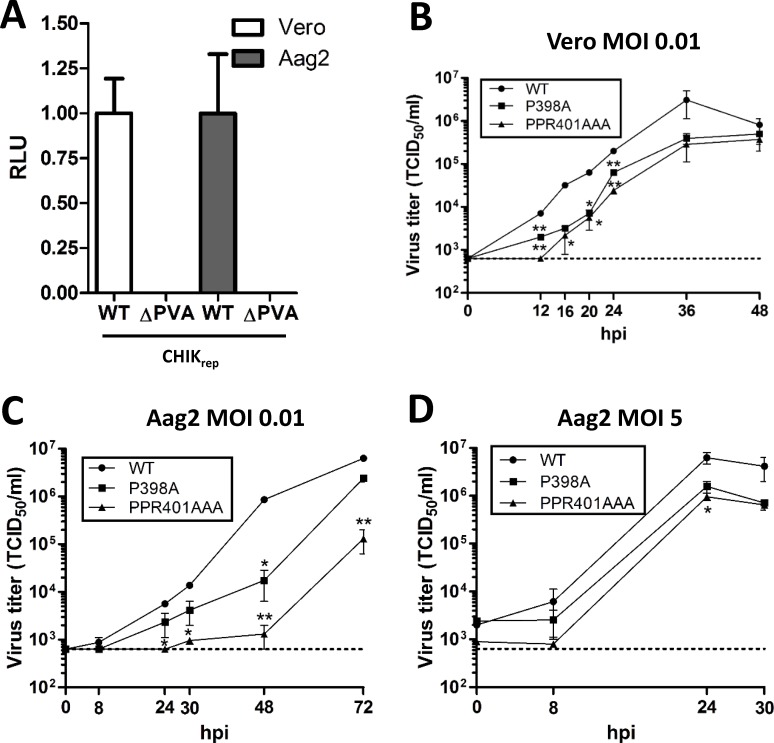
The P-rich motif is important but not essential for chikungunya virus replication in mammalian and mosquito cells.(A) Vero and Aag2 cells were transfected with in vitro transcribed RNA of CHIKrep or CHIKrepΔPVA and the relative luciferase expression was quantified at 24 hpt. Bars indicate the mean relative light units (RLU) ±standard error of the mean from three independent experiments. (B/C) Vero (B) and Aag2 (C) cells were infected in duplicate with CHIKIC, CHIKICP398A or CHIKICPPR401AAA at a multiplicity of infection (MOI) of 0.01. TCID50/ml was determined by EPDA on Vero cells at the indicated time-points. (D) Aag2 cells were infected in duplicate with CHIKIC, CHIKICP398A or CHIKICPPR401AAA at an MOI of 5 and the TCID50/ml was determined by EPDA on Vero cells at the indicated time-points. Asterisks indicate significant differences compared to the wild type virus by one-way ANOVA with Tukey’s post-hoc test on Log10 transformed data at each time-point (α = 0.05). The dotted line in panels B-D indicates the EPDA detection limit.